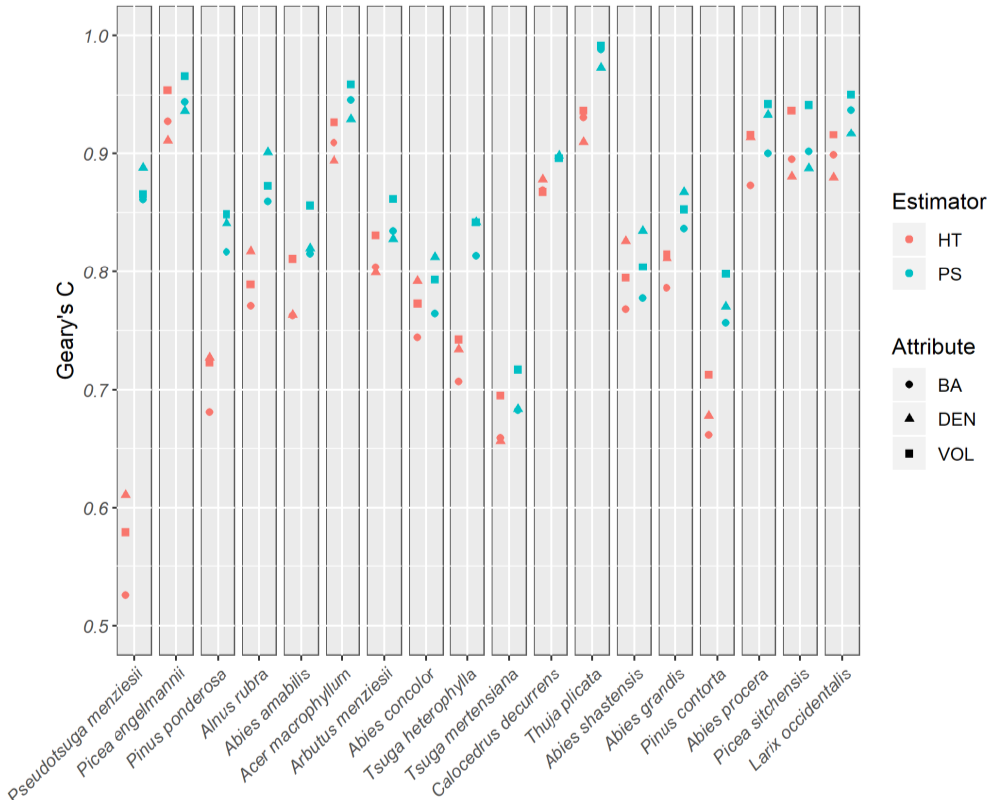
Figure 4. Geary’s C of the residuals attained from the post-stratified estimator and the Horvitz-Thompson estimator for each species-specific attribute. Geary’s C is computed using all available field plots. Species are ordered by their relative efficiencies for the VOL attribute.